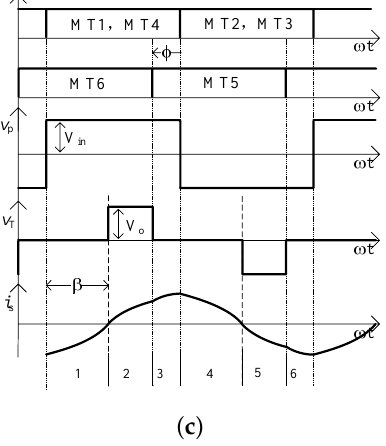
Figure 4. Steady-state waveforms of CCM2 operation with φ < β : ( a ) φ > 0; ( b ) φ = 0; ( c ) φ <